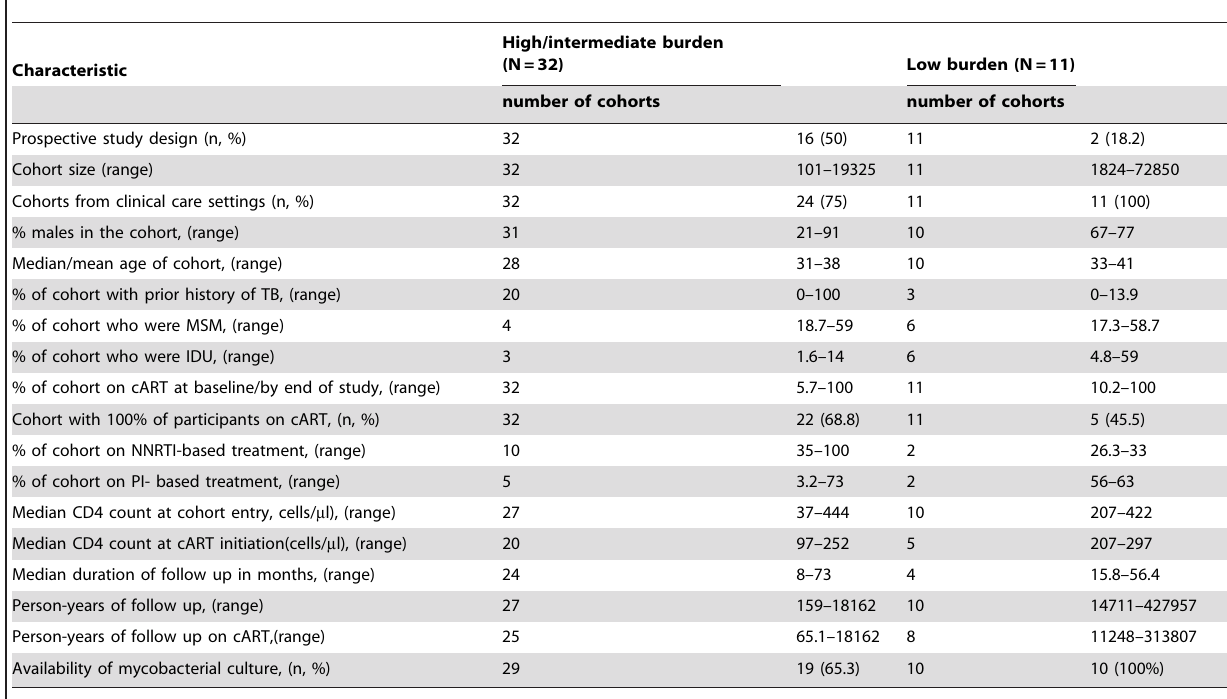
Table 1. Characteristics of study cohorts from high burden settings and from low burden settings.